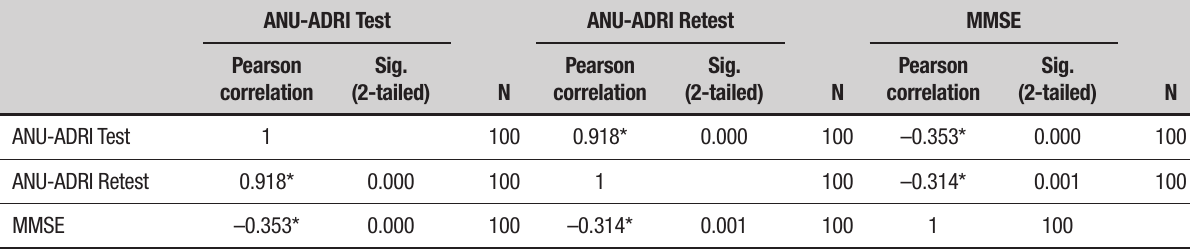
S2 Table. The relationship between ANU-ADRI Test with Retest and